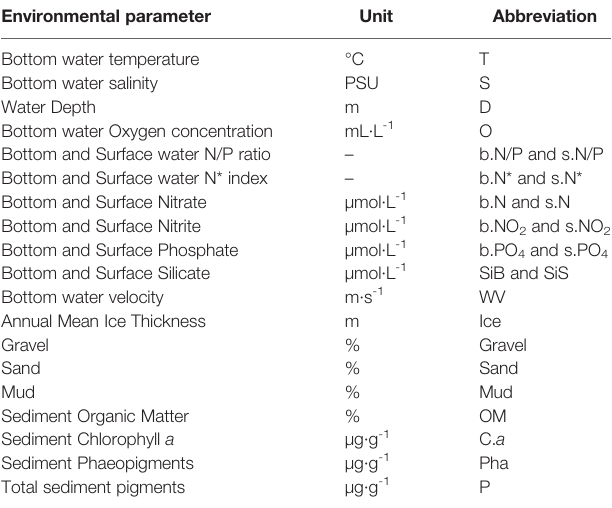
TABLE 1 | Environmental parameters considered for the statistical